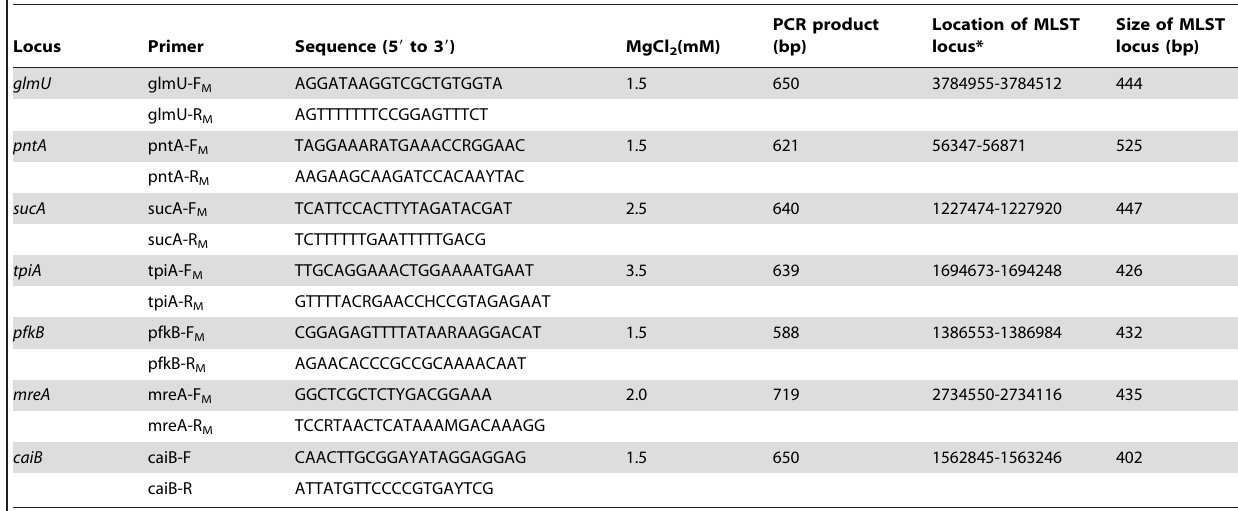
Table 1. MLST loci and